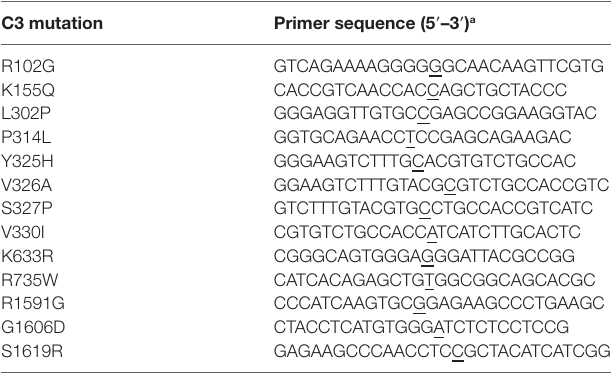
amino acid b cDna aTg + 1 snP